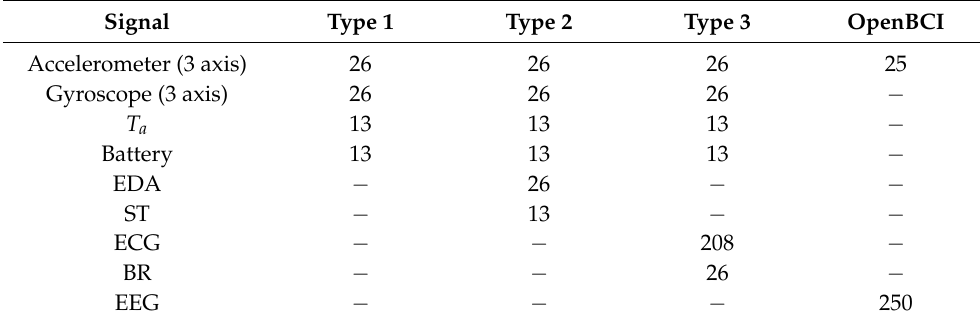
Table 4. Sampling frequency ( Hz ) used for each input signal. Signal Type